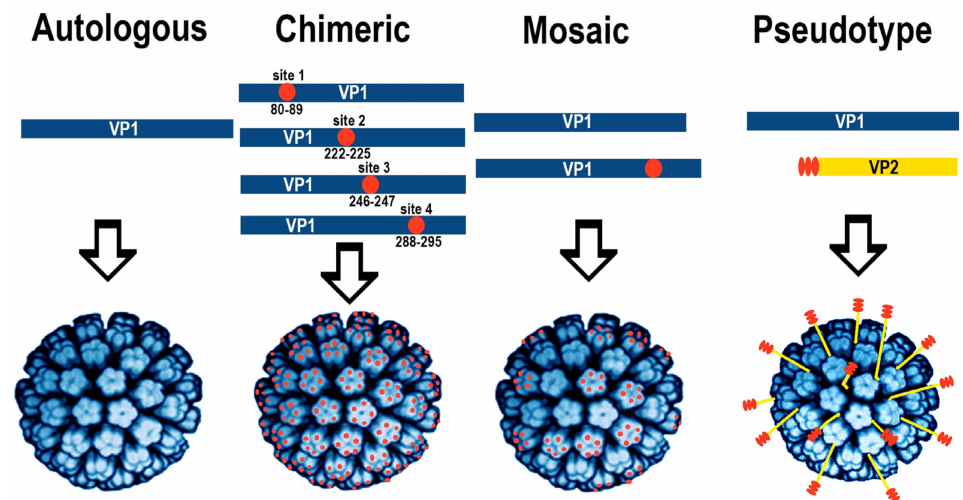
Figure 4. Strategies for the production of autologous, chimeric, mosaic, and pseudotype VLPs. For the generation of chimeric VLPs, four potential insertion sites were used that are located on flexible and variable regions of VP1. Mosaic VLPs are generated by the simultaneous expression of non-modified VP1 with a VP1-foreign sequence fusion protein. Pseudotype VLPs can be generated by the co-expression of VP1 and a VP2-foreign sequence fusion